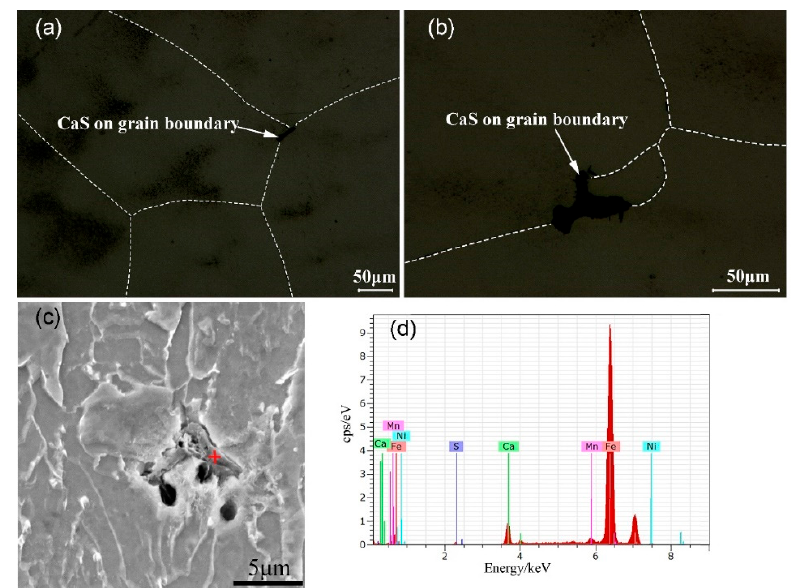
Figure 15. CaS inclusions in grain boundaries found in the CET zone, where the red cross is the location of EDX analysis. ( a ) CaS in the boundary of austenite grain, ( b ) CaS in the boundary of austenite grain, ( c ) illustration of EDX location, ( d ) results of energy spectrum analysis.